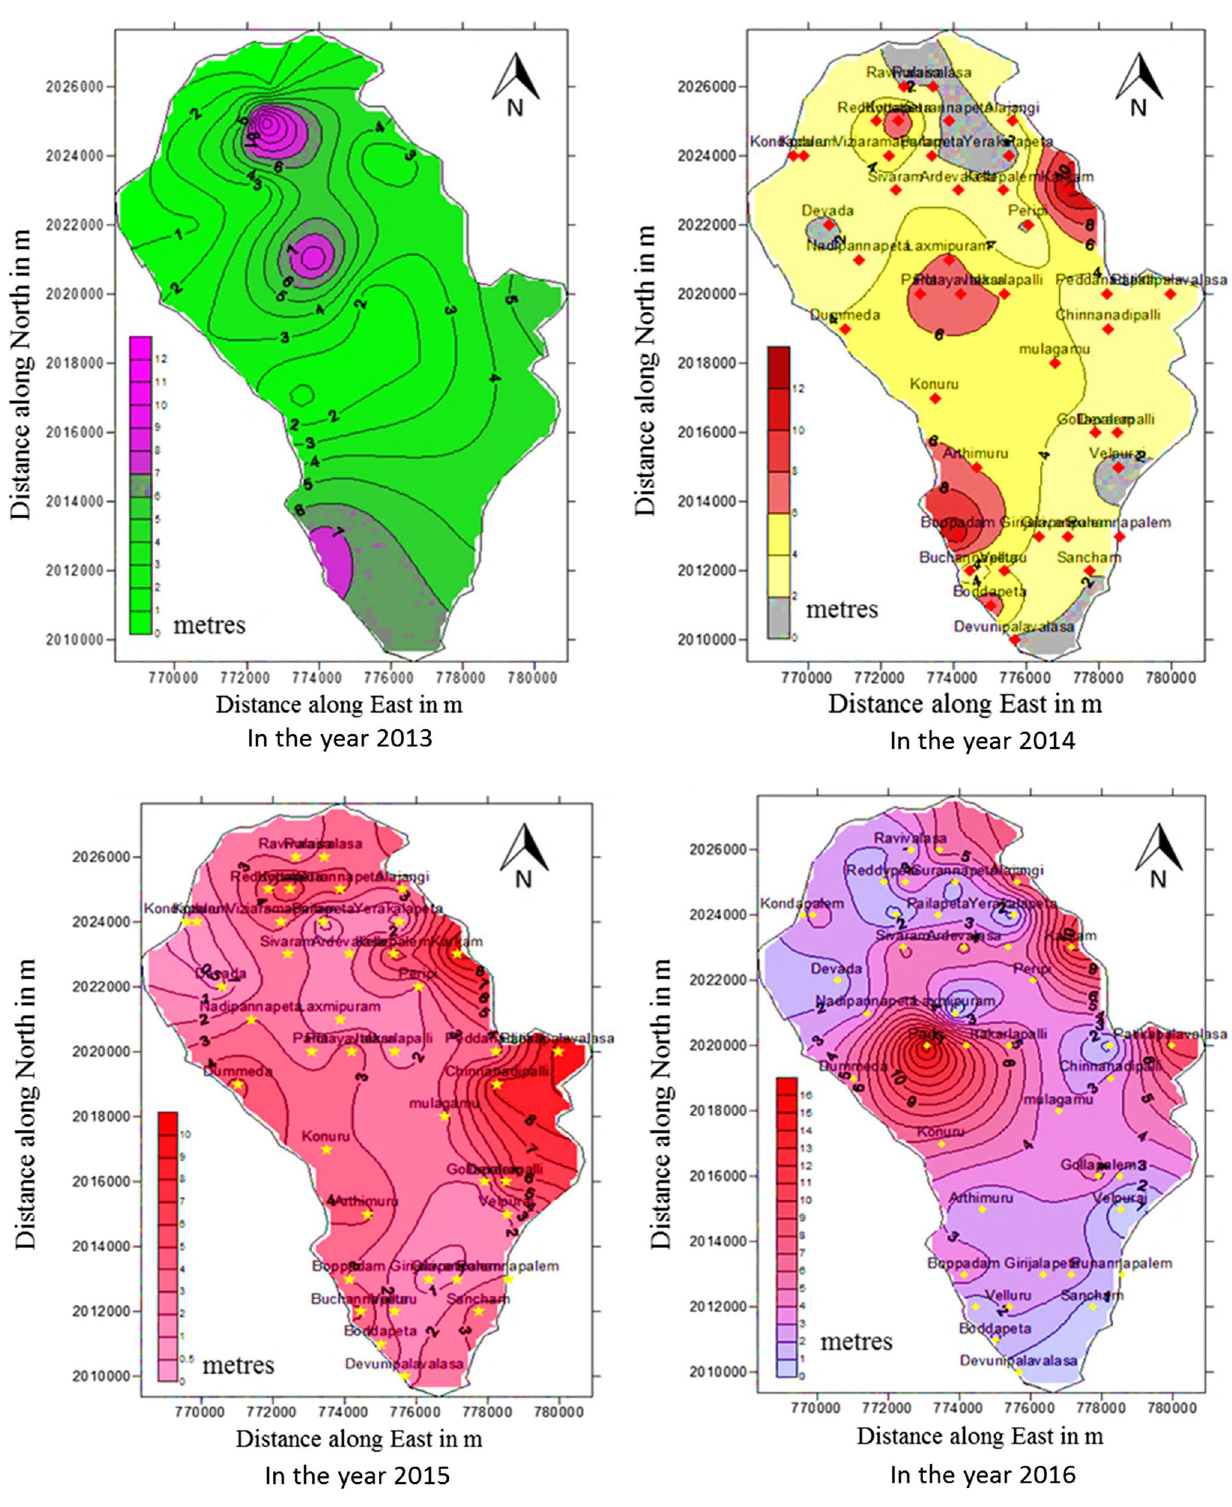
Fig. 4 Contour maps of groundwater fluctuations of Kandivalasa river sub-basin in